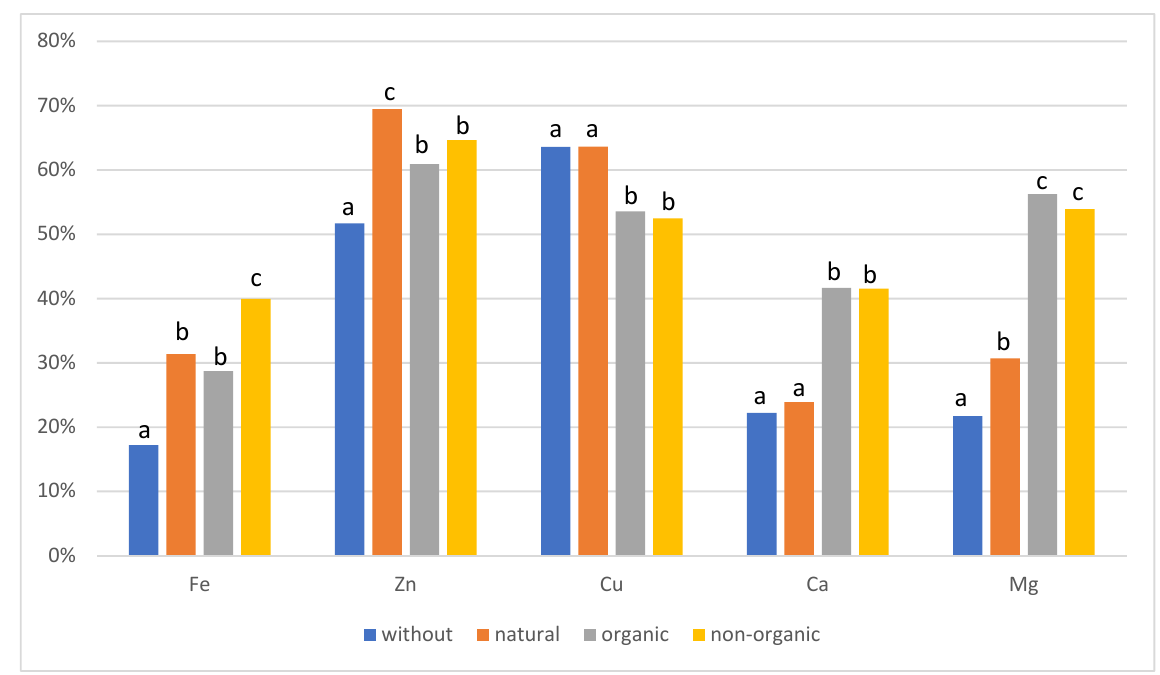
Figure 2. Bioavailability in buckwheat bread, a, b, c statistical differences between additives (seeds, supplements).